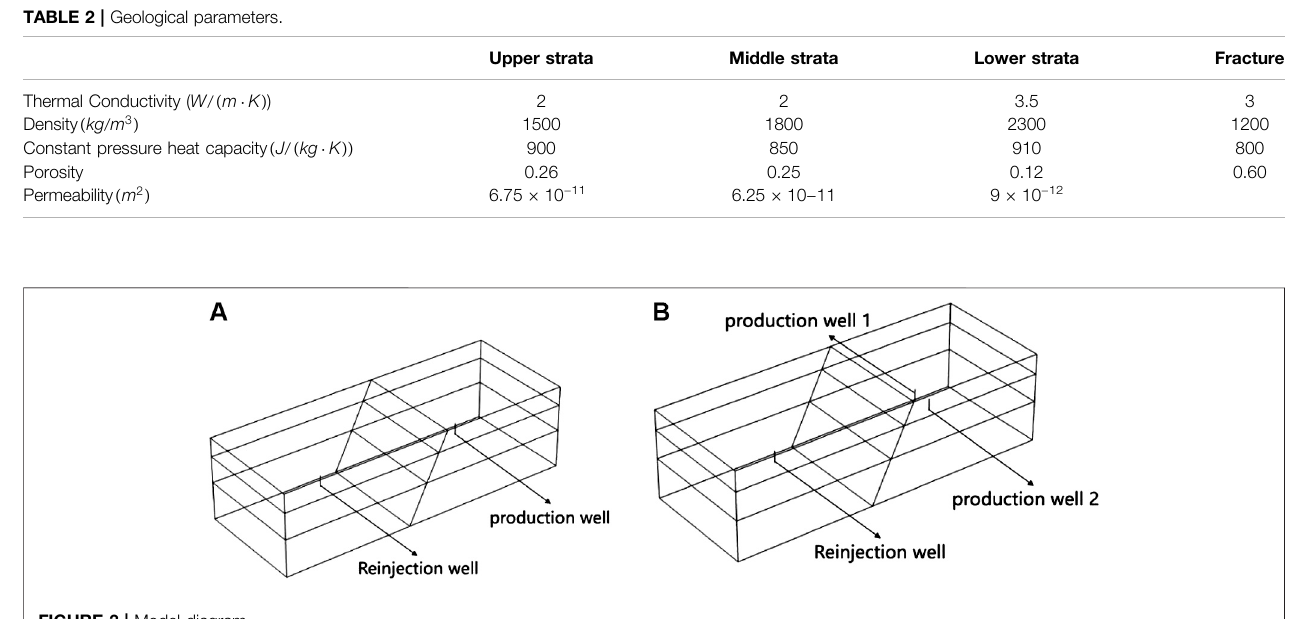
FIGURE 3 | Model diagram.